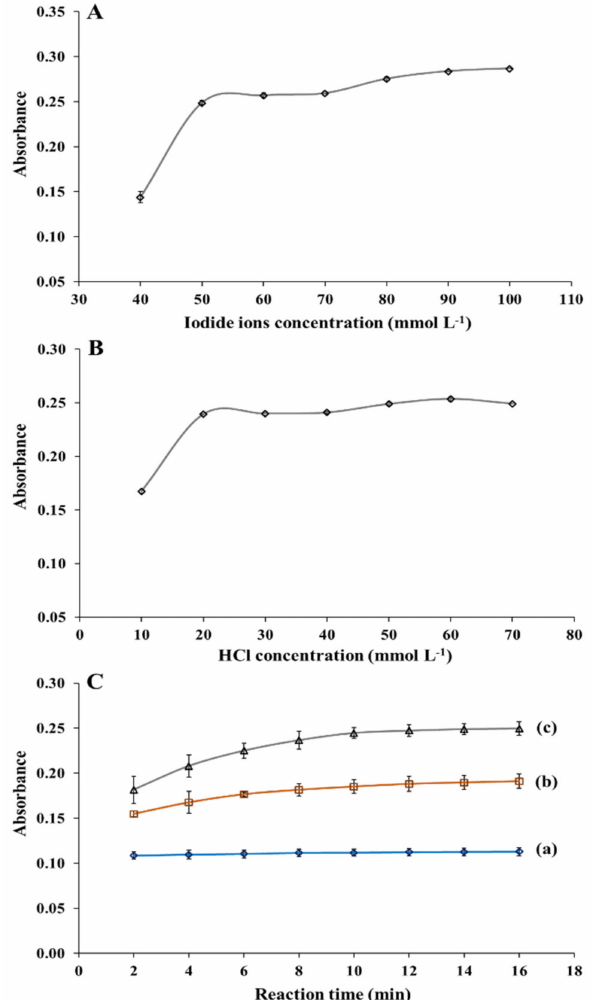
Figure 3. Absorbance (0.600 mg L − 1 nitrite) of the developed spectrophotometric method with ( A ) different iodide ions concentration (HCl concentration, 50 mmol L − 1 ; reaction time, 10 min) and ( B ) different HCl concentration (iodide ions concentration, 50 mmol L − 1 ; reaction time, 10 min). ( C ) Effect of reaction time on absorbance at nitrite ions concentrations of (a) 0.200, (b) 0.400, and (c) 0.600 mg L − 1 (iodide ions concentration, 50 mmol L − 1 ; HCl concentration, 20 mmol L − 1